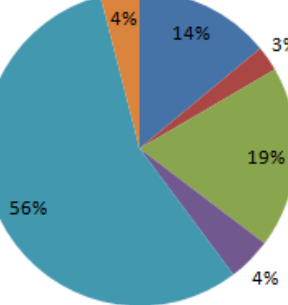
Figure 4. EU polity evaluations (n = 422).